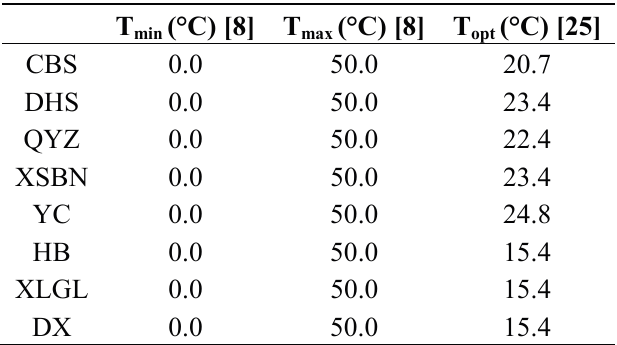
Table 2. Models’ temperature parameters in different land cover types. T are the biological minimum temperature, maximum temperature, and optimal temperature during the growing